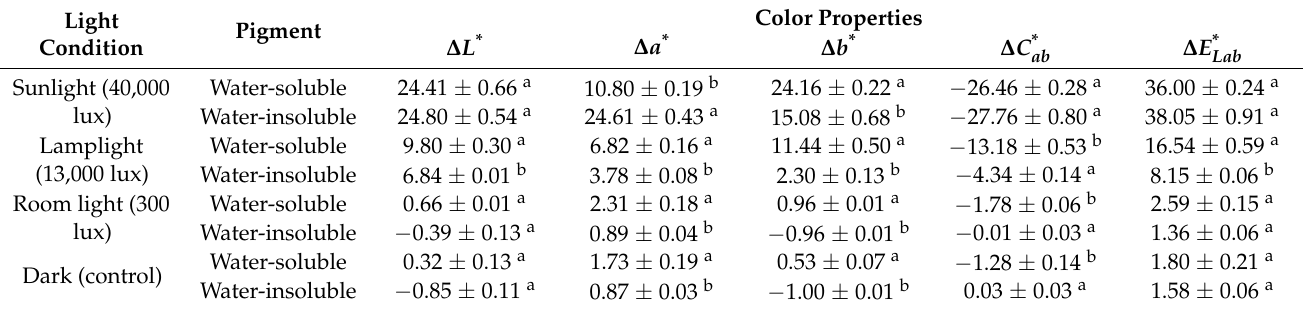
Table 8. Light stability of water-soluble and water-insoluble gardenia blue pigments (color